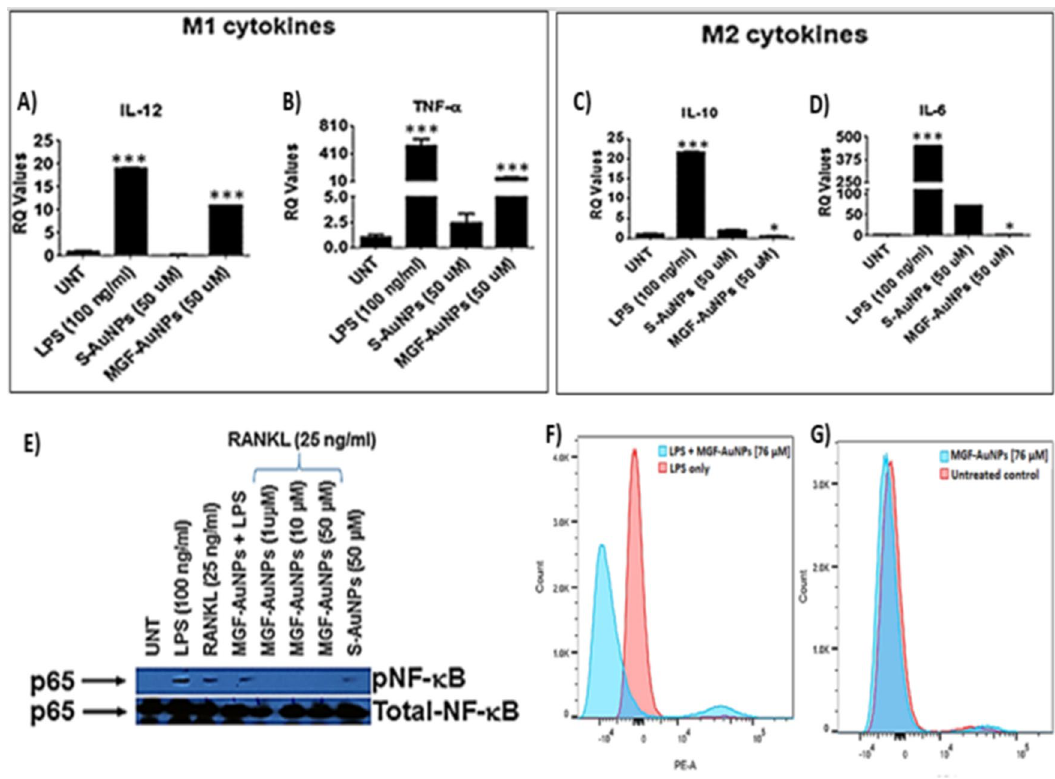
Figure 8. MGF-AuNPs induced polarization of macrophages and inhibits NF-κB activation. ( A – D ) RAW 264.7 cells were pretreated with either Starch-AuNPs (S-AuNPs as control), or MGF-AuNPs for 2 h and treated either with LPS (100 ng/mL) or RANKL (25 ng/mL) or left untreated for 4 h. RNA was isolated from treated and untreated samples and analyzed for IL-12, TNF-α, IL-10, and IL-6 by real time PCR using probes from TaqMan, Applied Biosystems. ( E ). RAW 264.7 cells were either treated with LPS (100 ng/mL) or Starch-AuNPs (S-AuNPs as control), or MGF-AuNPs or left untreated for 30 min. The cells were lysed with 1X Lamellae buffer and lysates were run on PAGE gel and transferred onto nitrocellulose membranes. The membranes were than probed for either phospho- NF-κB or NF-κB using respective antibodies. ( F ). The RAW 264.7 cells were cultured overnight in 6 well plates and pre-treated with different doses of MGF-AuNPs (0, 32 µg/mL) for 3 h. Subsequently the cells were washed and treated with LPS (100 ng/mL) for 45 min. After incubation with LPS the cells were washed, fixed and permeabilized. After permeabilization the cells were stained with PE conjugated anti-NF-κB antibody for 45 min. The cells were washed and analyzed using flow cytometry. ( G ) The RAW 264.7 cells were cultured overnight in 6 well plates and pre-treated with different doses of MGF-AuNPs (0, 32 µg/mL) for 45 min. Cells were fixed, permeabilized and stained with PE conjugated anti-NF-κB antibody for 1 h and analyzed by flow